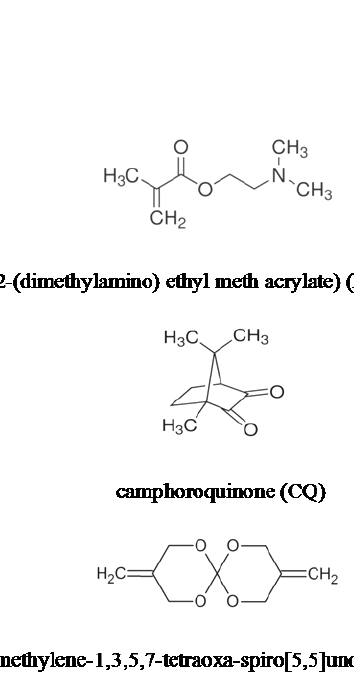
Figure 5. The chemical structure of materials used in the four groups of